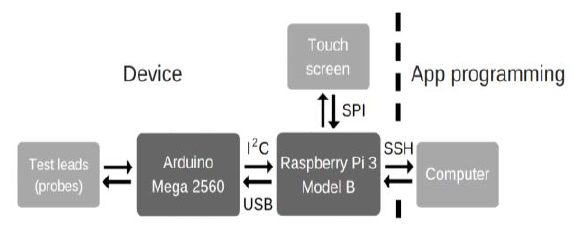
Fig. 2. Structure of the system during